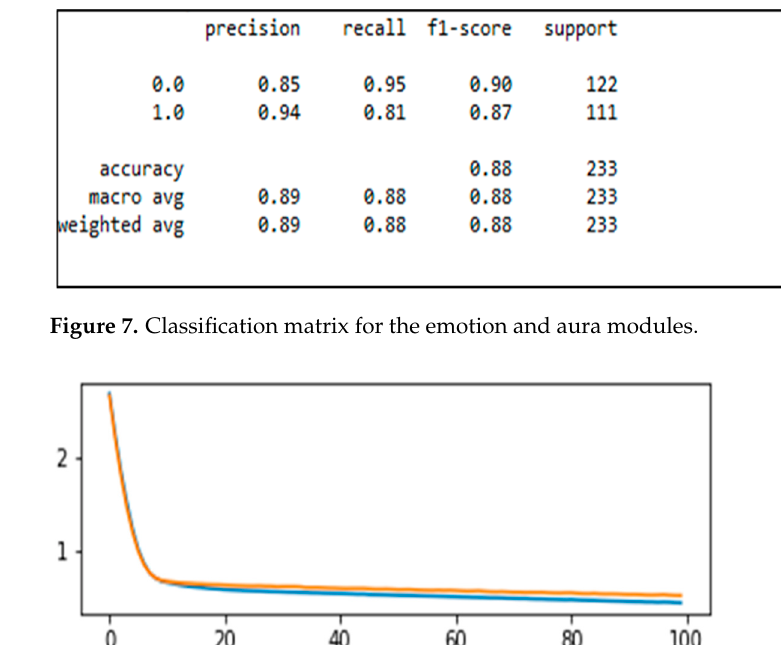
Figure 6. Training and validation accuracy (top) and loss (down) for the human aura module.